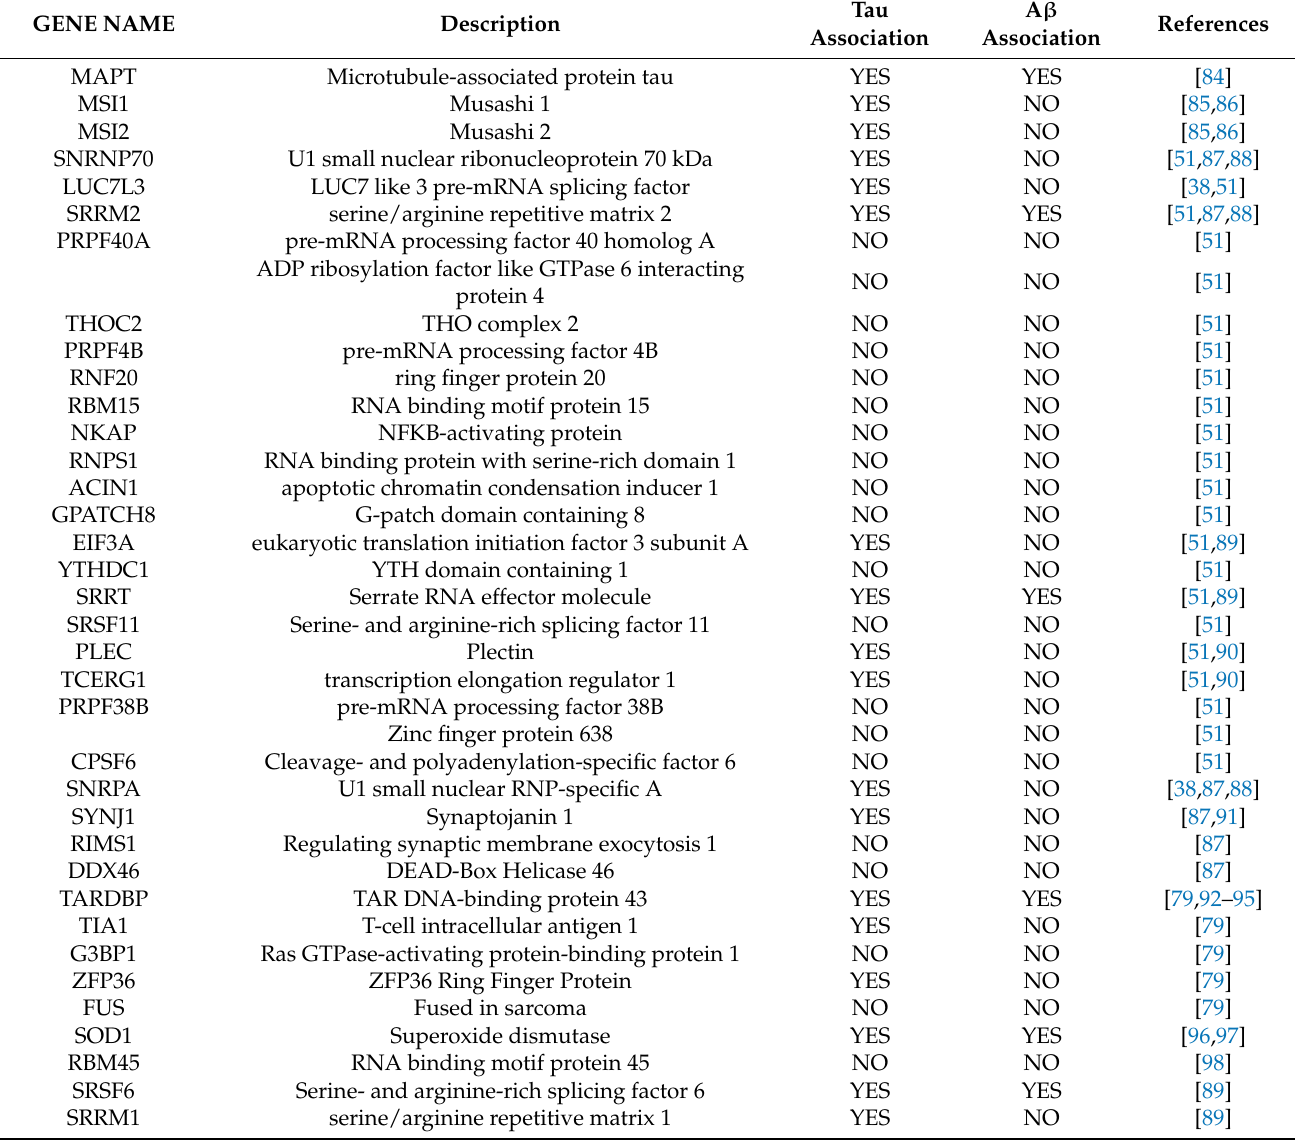
Table 1. RBPs that aggregate in